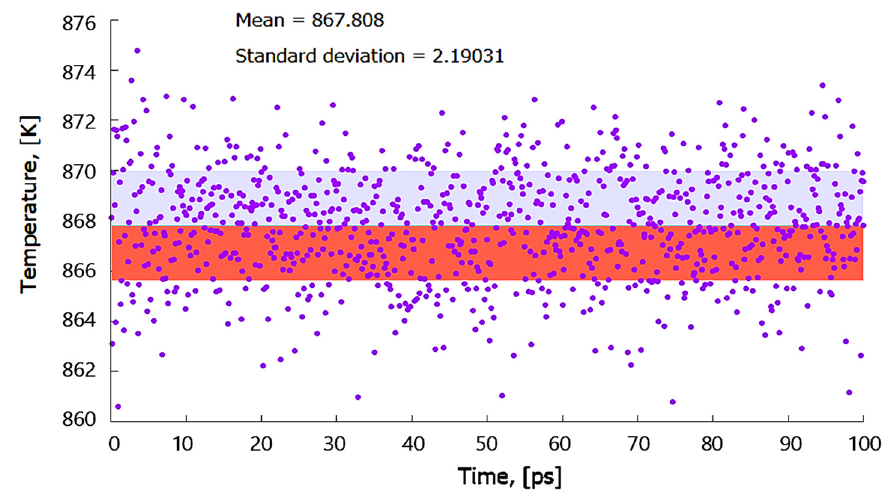
that it is an approximation that shows potential for application to model systems that involve molten Al metal. model systems that involve molten Al metal.